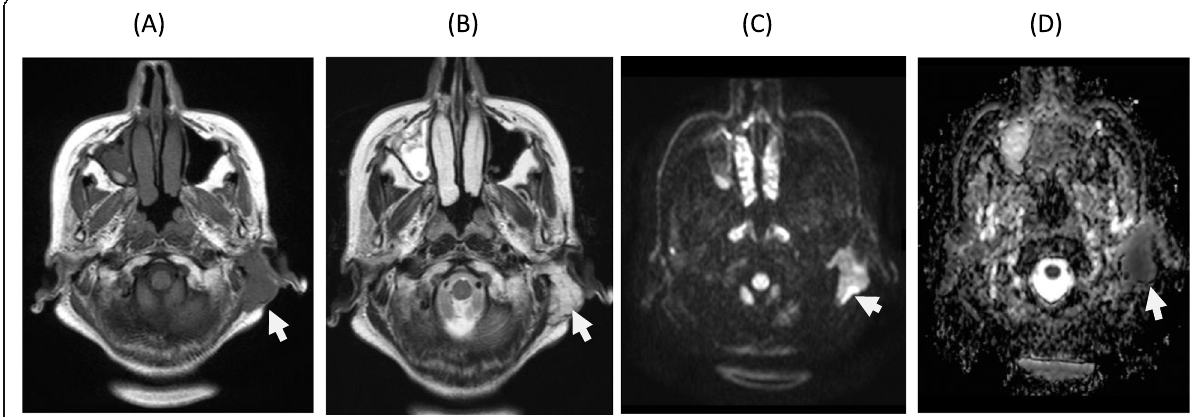
Fig. 3 Pathologically proven recurrent adenoid cystic carcinoma of the left parotid gland following parotidectomy and adjuvant radiotherapy. a Axial T1-weighted image (T1WI) showing a well-defined lesion of low signal intensity at the operative bed of the previous left parotidectomy. b Axial T2-weighted image (T2WI) showing the high signal intensity of the lesion. c Diffusion-weighted imaging (b1000) revealing the hyperintense pattern of the lesion. d Apparent diffusion coefficient (ADC) map revealing the hypointense pattern of the lesion, with a mean ADC value of 0.96 × 10 − 3 /mm 2 suggestive of tumour